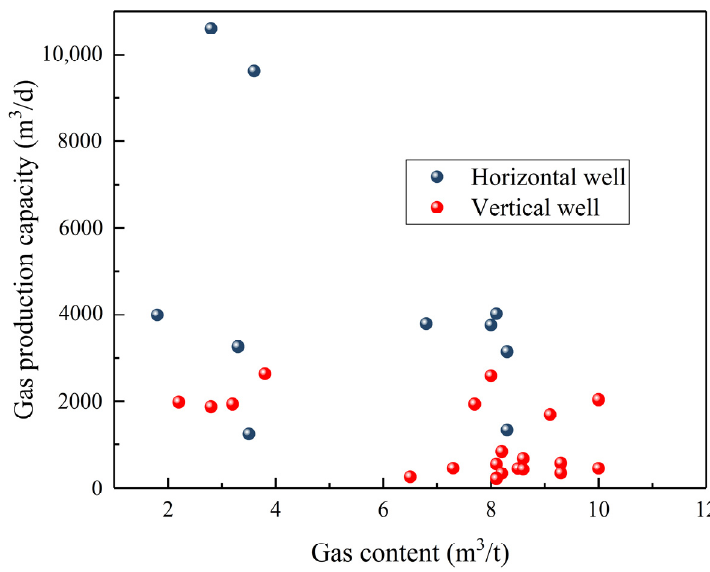
Figure 8. The relationship between gas production and gas